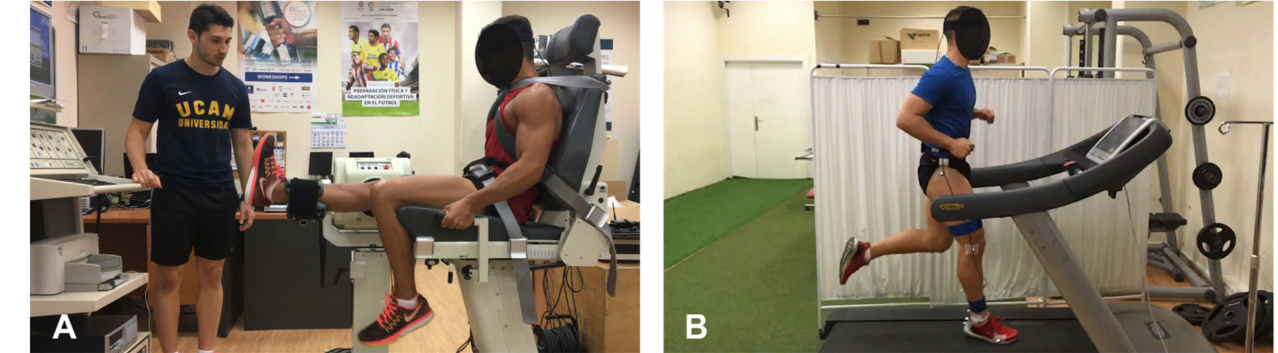
Figure 2. Setup of the peripheral fatigue protocol ( A ) and the central fatigue protocol ( B